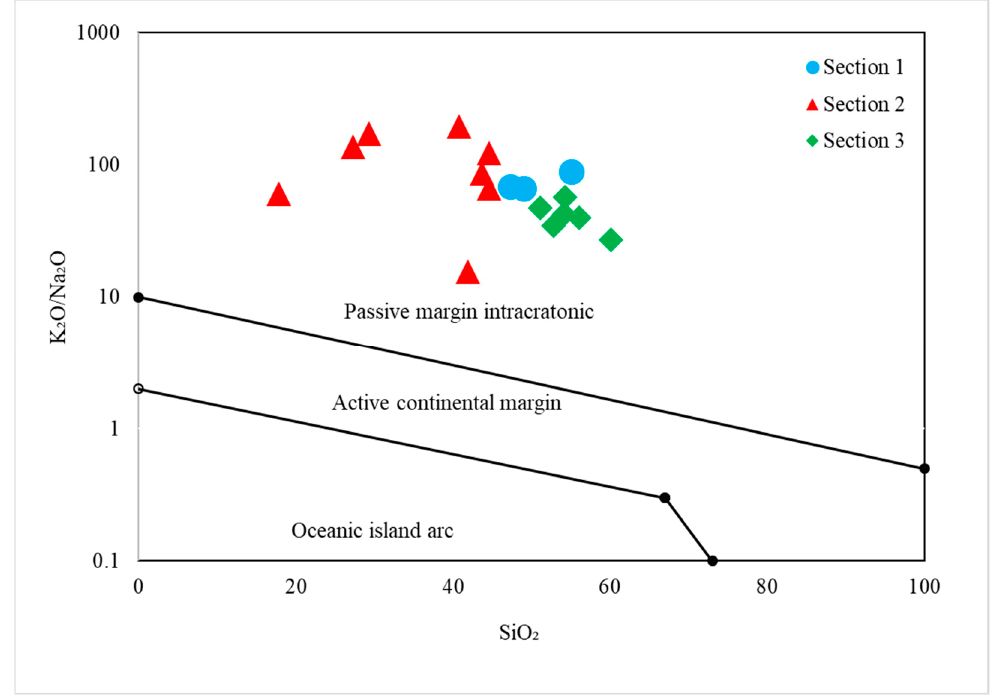
J. Mar. Sci. Eng. 2022 , 10 , x FOR PEER REVIEW Figure 10. Plot of SiO 2 versus K 2 O/Na 2 O for shales of the Chichali Formation.